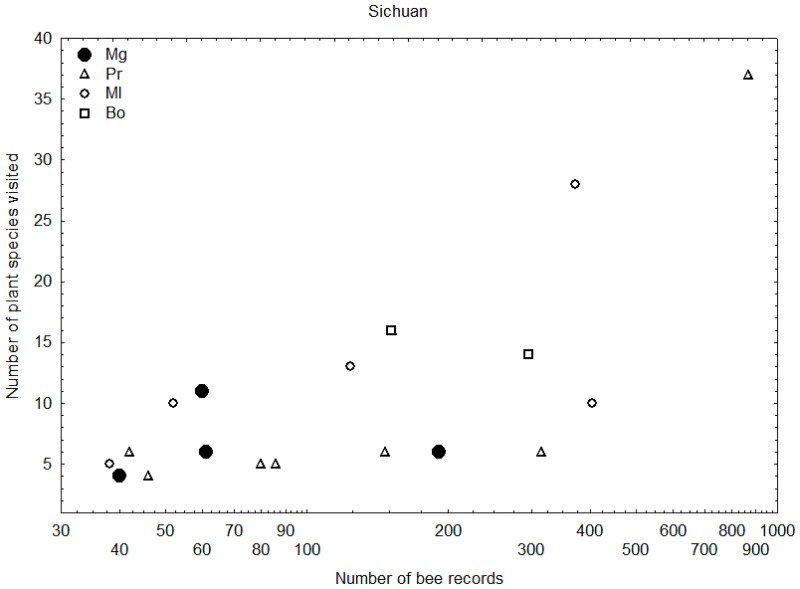
Relationship of number of food-plant species recorded per bumblebee species to number of bee records per bumblebee species.For species of the subgenera Megabombus (black spots), Pyrobombus (triangles), Melanobombus (circles), and Bombus s. str. (squares). Species with few food-plant-species records relative to the number of bee records are interpreted as more specialised in their fewer food-plant choices (Data from Sichuan [13]).